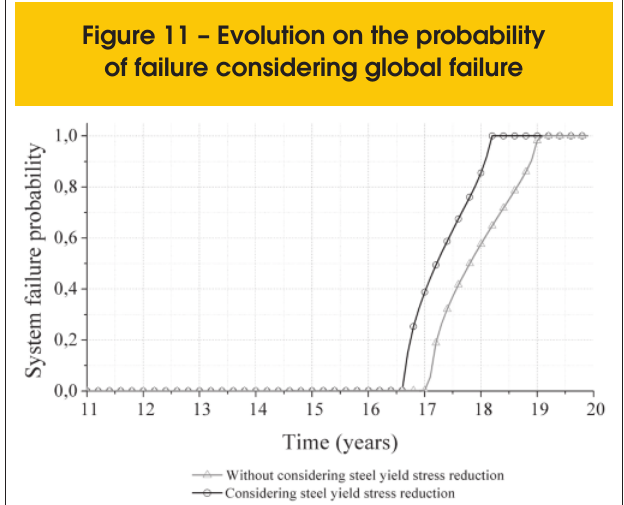
Figure 11 – Evolution on the probability of failure considering global